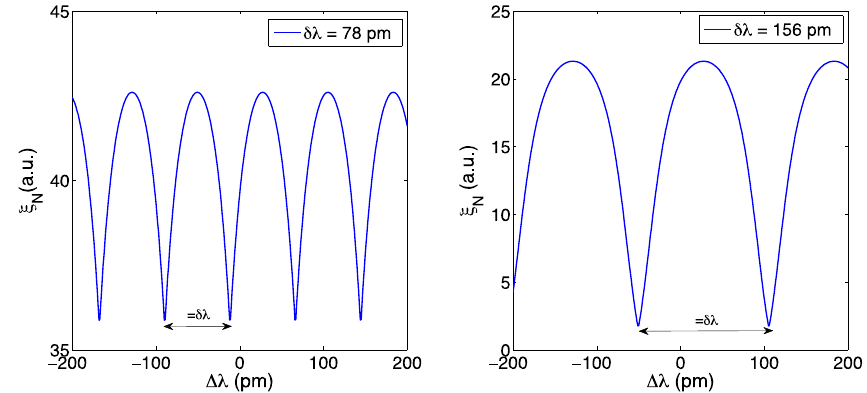
Figure 14. Output of the KLT for a simulated FBG, with wavelength shift Δ λ ranging from − 200 pm to +200 pm. The charts are obtained for a wavelength grid resolution of 78 pm ( left ) and 156 pm ( right ).